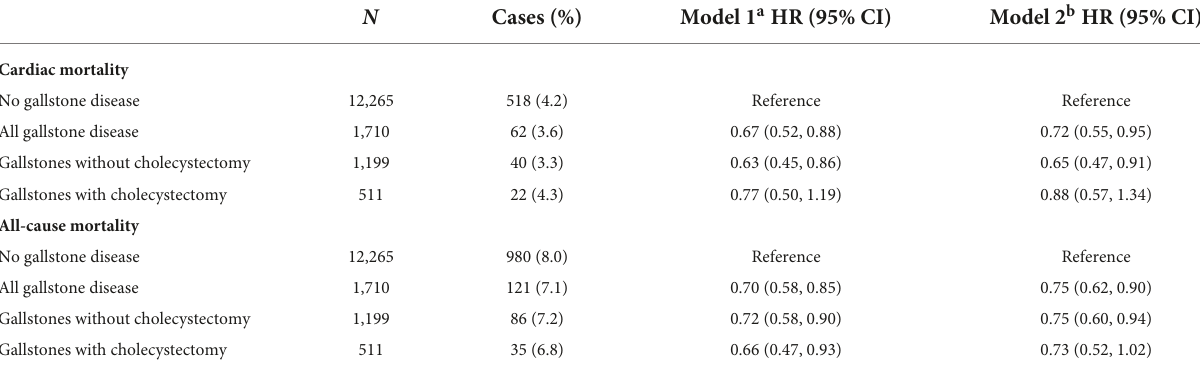
TABLE 2 Multivariable adjusted hazard rate ratio (HR) of cardiac mortality and all-cause mortality regarding the presence of gallstone disease ( n = 13,975).